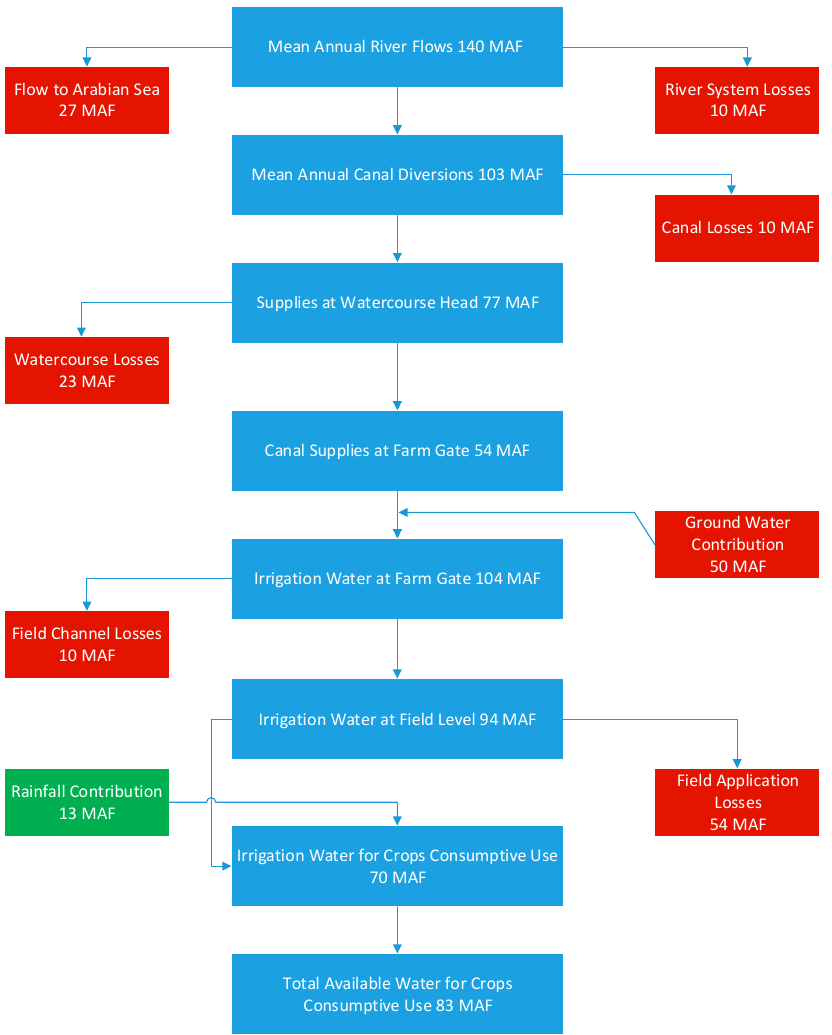
Figure 6. Pakistan’s water budget and associated